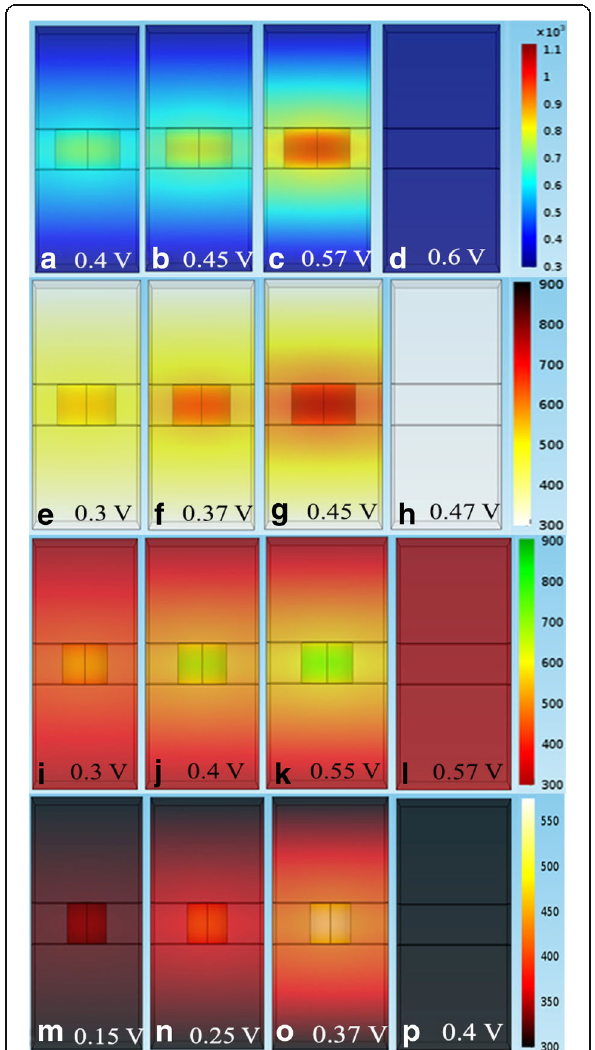
Fig. 18 Calculated temperature maps extracted from the electro thermal simulations for applied voltages a 0.4 V, b 0.45 V, c 0.575 V, and d 0.6 V for sample P (500 °C annealed); e 0.3 V, f 0.375 V, g 0.45 V, and h 0.475 V for sample Q (400 °C annealed); i 0.3 V, j 0.4 V, k 0.55 V, and l 0.575 V for sample R (300 °C annealed); m 0.15 V, n 0.25 V, o 0.375 V, and p 0.4 V for sample S (200 °C annealed) across the CF geometry of length t ox = 20 nm. Different bias points are considered for the devices so that the reset transition for each device can be visualized easily